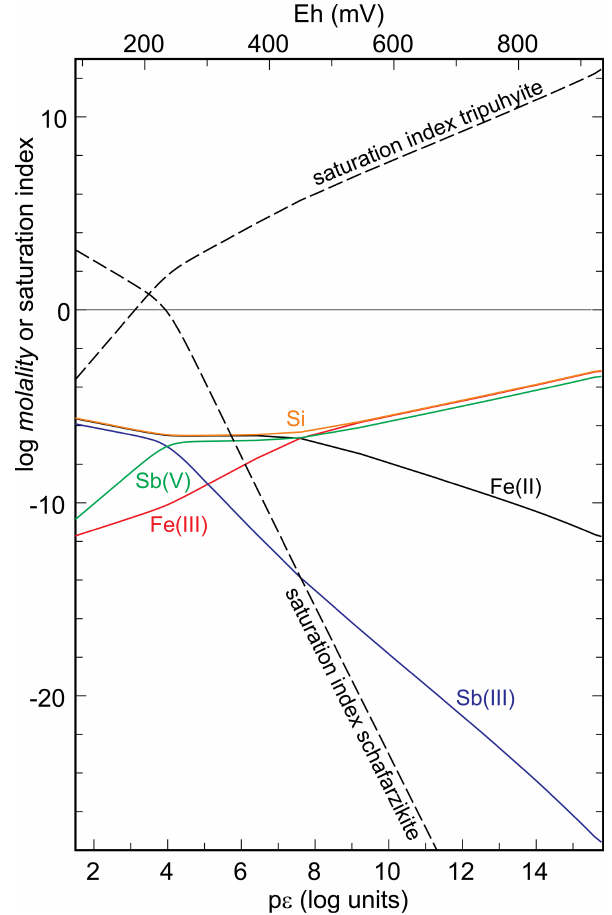
Figure 6. Graphical summary of the results of a forward simulation. A Ca-Mg-SO 4 solution with pH = 5.7 was equilibrated with chap- manite under variable redox ( p(cid:15) ) conditions. Shown are the molal- ities of the aqueous species and saturation indices of schafarzikite and tripuhyite. For details, see